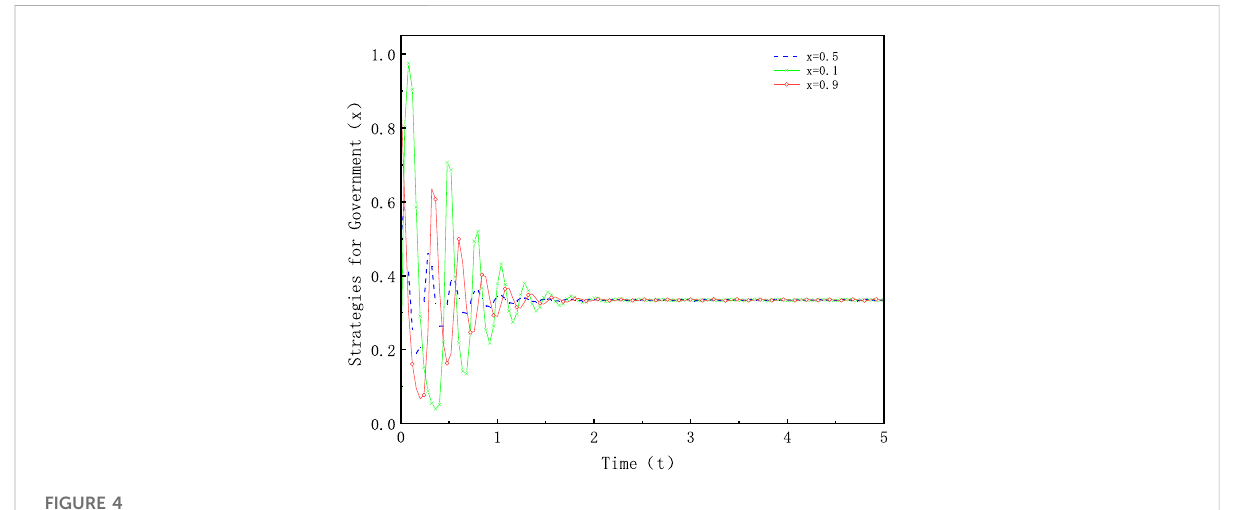
FIGURE 4 Strategies evolution of government under different initial